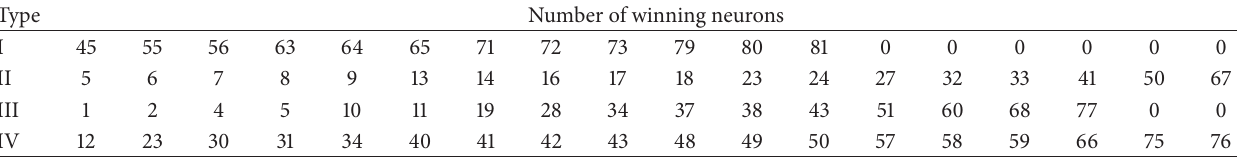
Table 7: Number of winning neurons corresponding to fault class of SOM neural network optimized by improved PSO algorithm. Type Number of winning neurons